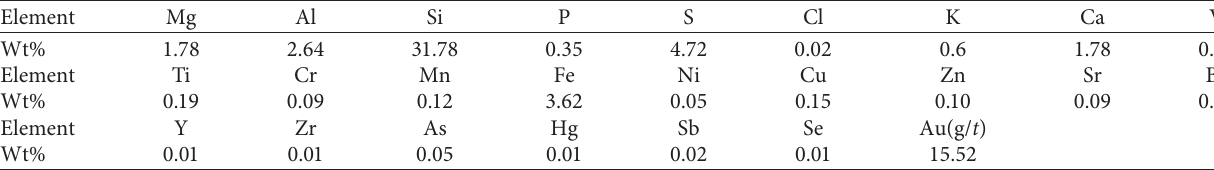
Table 1: Chemical composition of the sample.